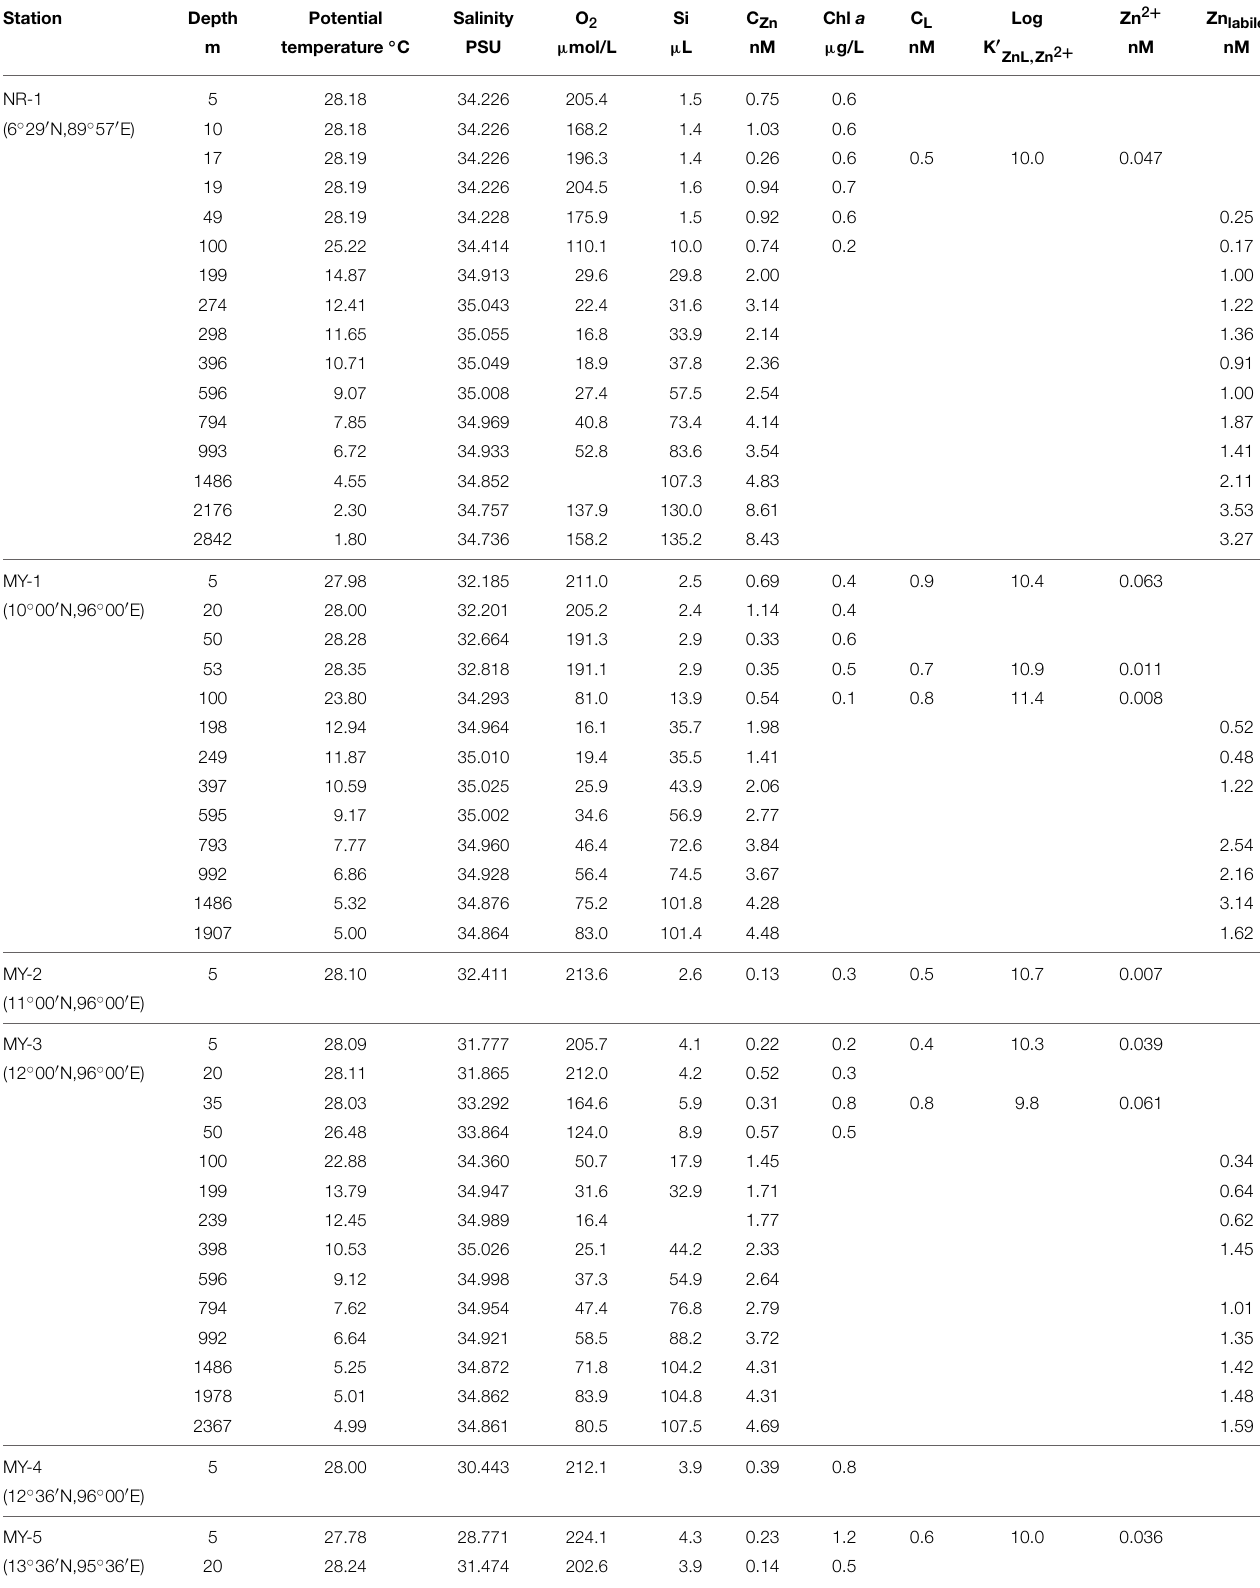
TABLE 1 | Seawater analysis results and associated hydrographic data obtained in this study. Station Depth